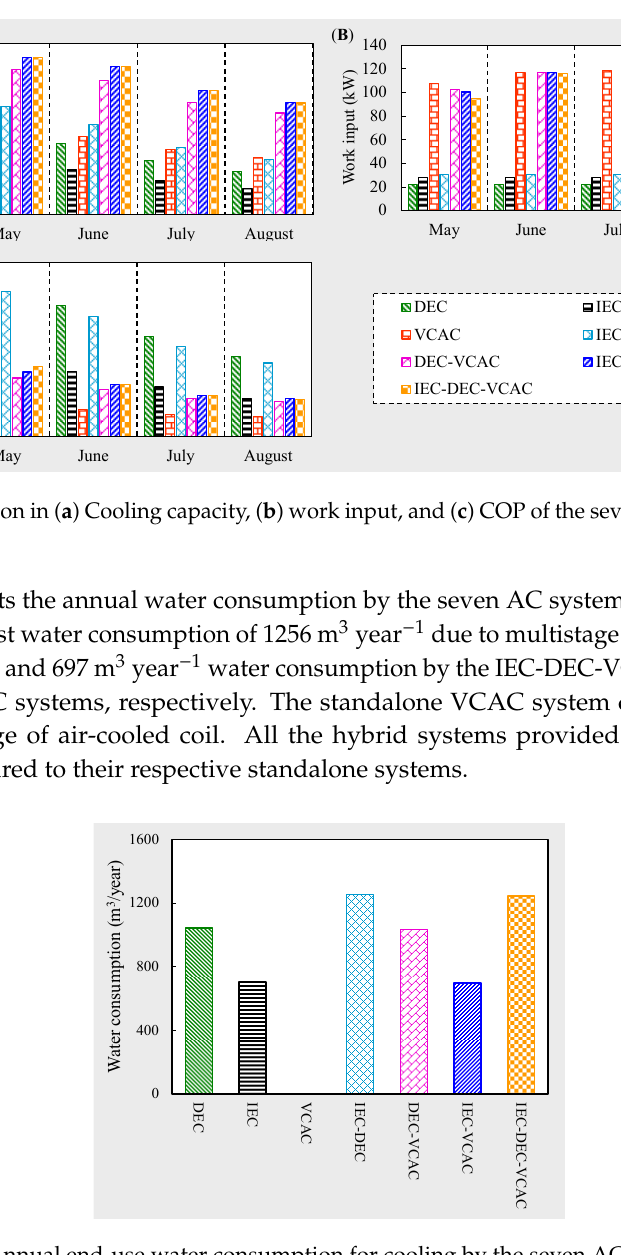
Figure 12. Annual end-use water consumption for cooling by the seven AC configurations.